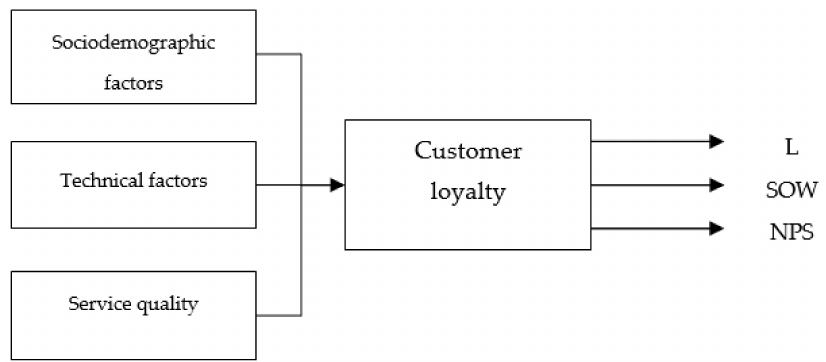
Figure 4. Conceptual model presenting the projection of the loyalty of the customers of the auto repair shops. Source: authors’ study.